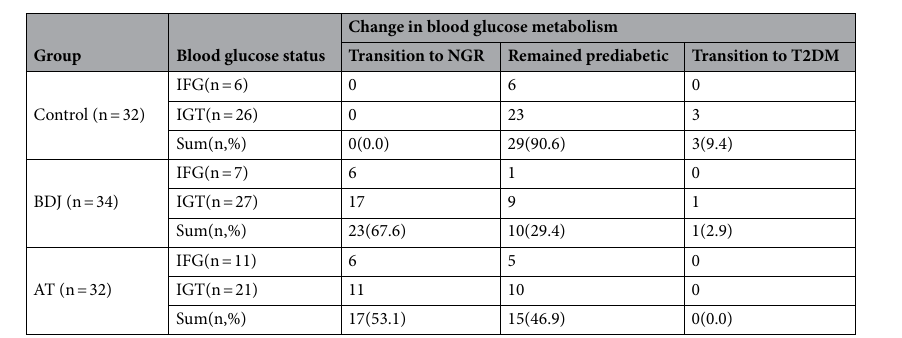
Table 7. Change in blood glucose metabolism. BDJ, Baduanjin; AT, aerobic training; IFG, impaired fasting glucose; IGT, impaired glucose tolerance; NGR, normal glucose regulation; T2DM,type 2 diabetes mellitus.